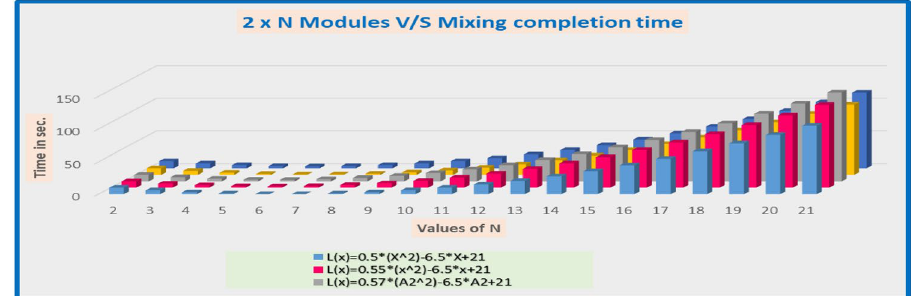
Fig. 9 Time required for 100 % completion of mixing using different 2 × N mixing